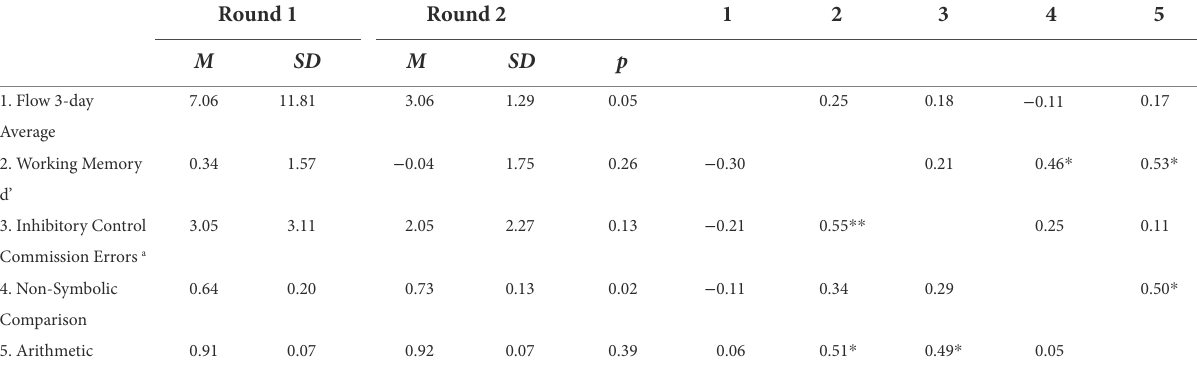
TABLE 3 Descriptive statistics and Spearman’s rho correlation coefficients for participants with complete data ( n =